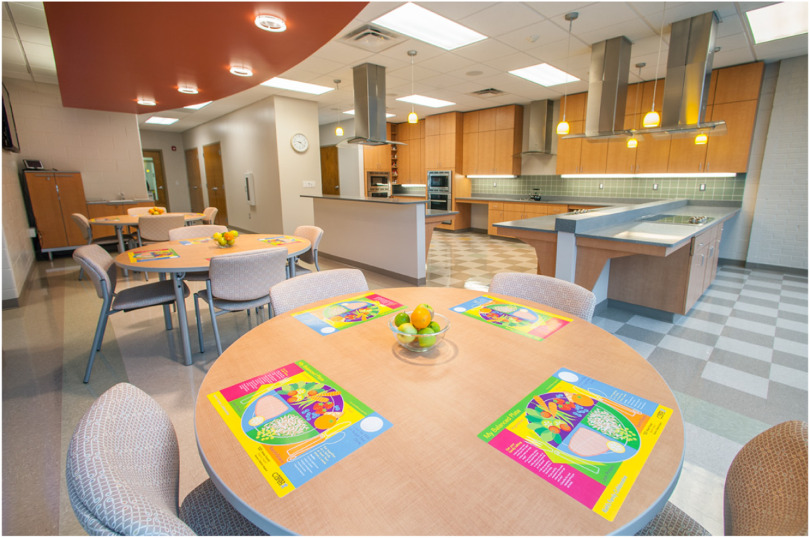
Teaching kitchen.